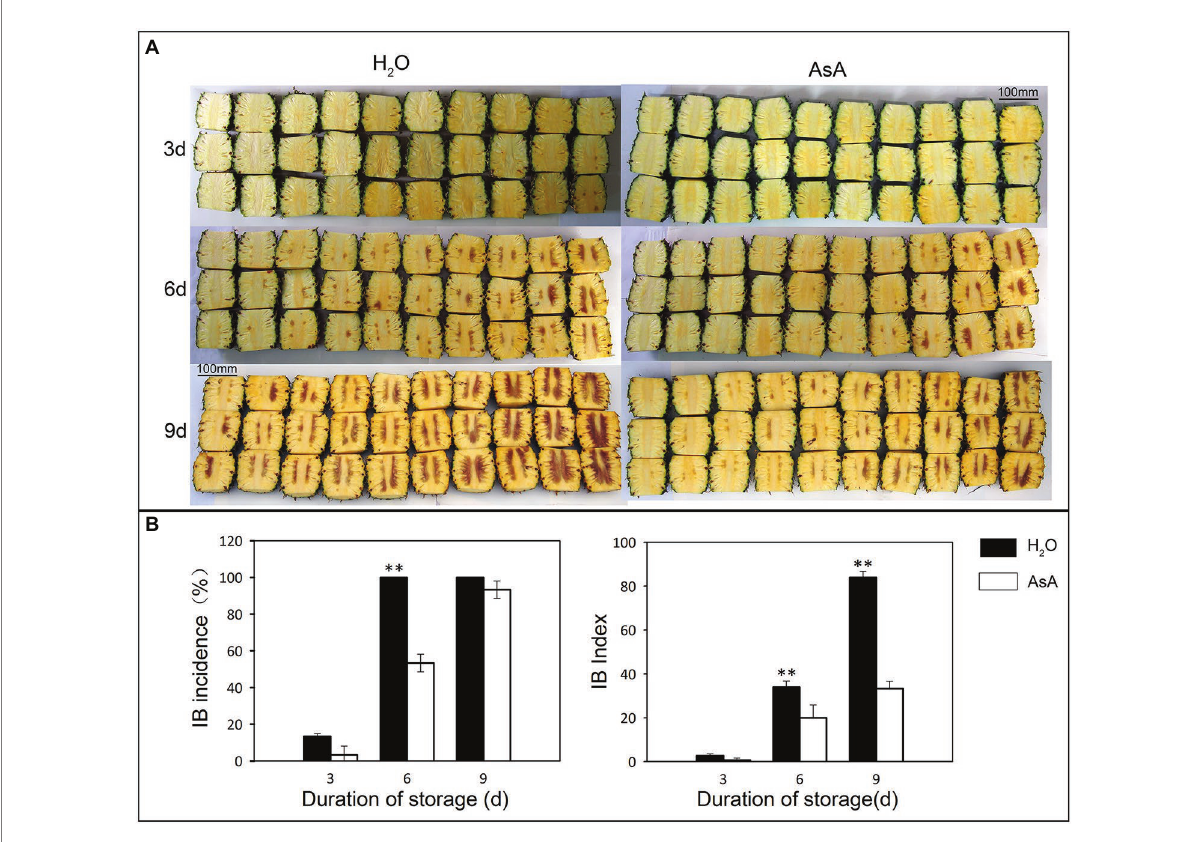
FIGURE 2 Effects of exogenous ascorbic acid treatment on internal browning (IB) in pineapples at different storage timepoints. The phenotype (A) IB incidence and IB index (B) of different treatment groups. ** p ≤ 0.01 (Student’s t